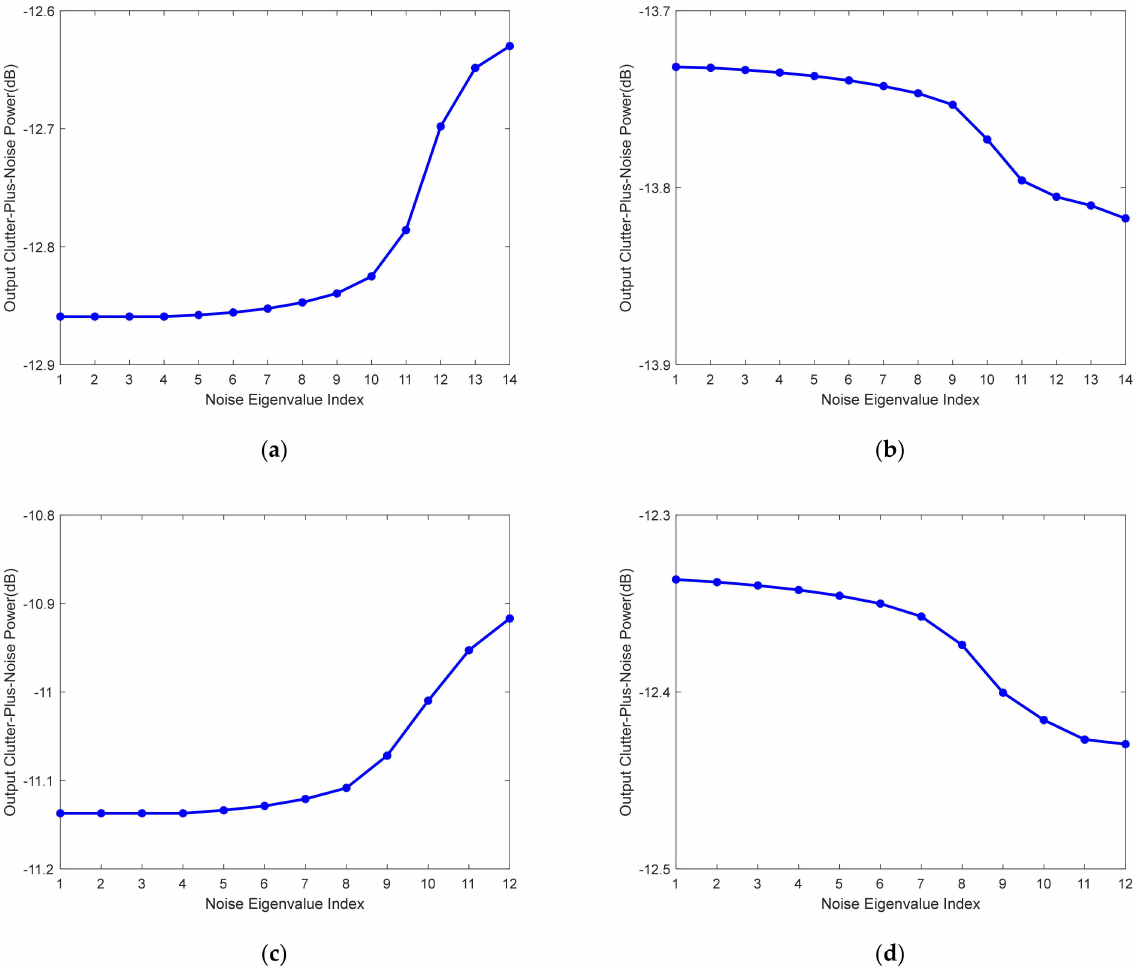
Figure 3. The output clutter-plus-noise powers versus the noise eigenvalues. ( a ) V = 150 m/s, L = 20; ( b ) V = 150 m/s, L = 30; ( c ) V = 300 m/s, L = 20; ( d ) V = 300 m/s, L =